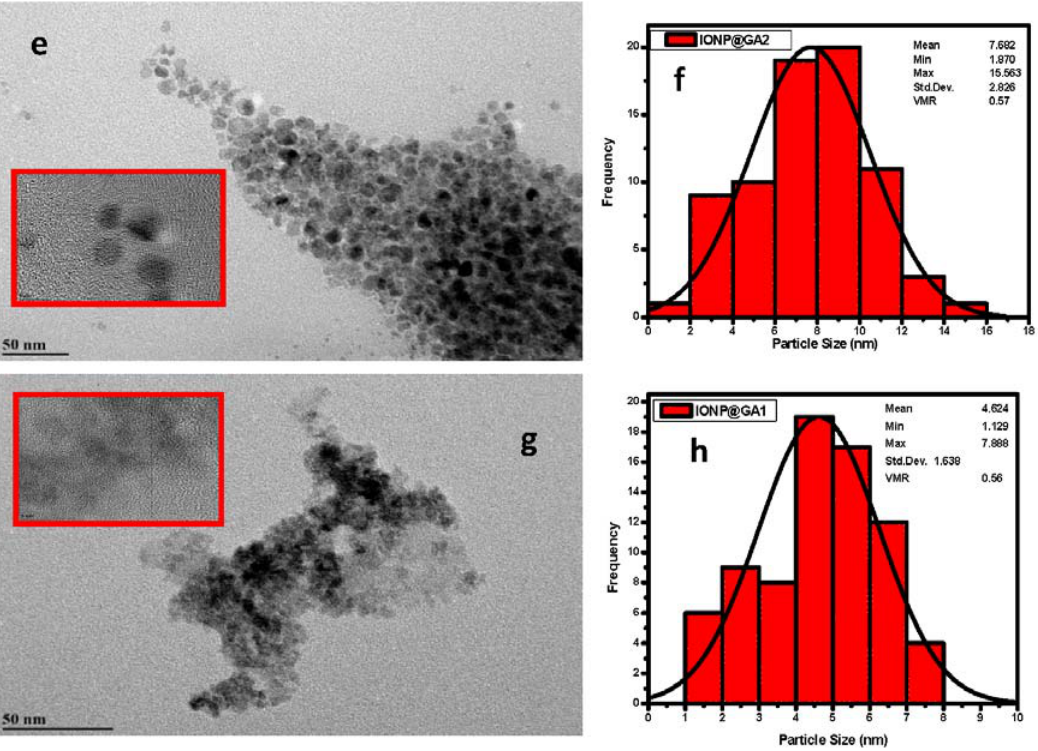
Figure 4. HRTEM images ( a , c , e , g ) and particle size distribution ( b , d , f , h ) of IONP@GA.